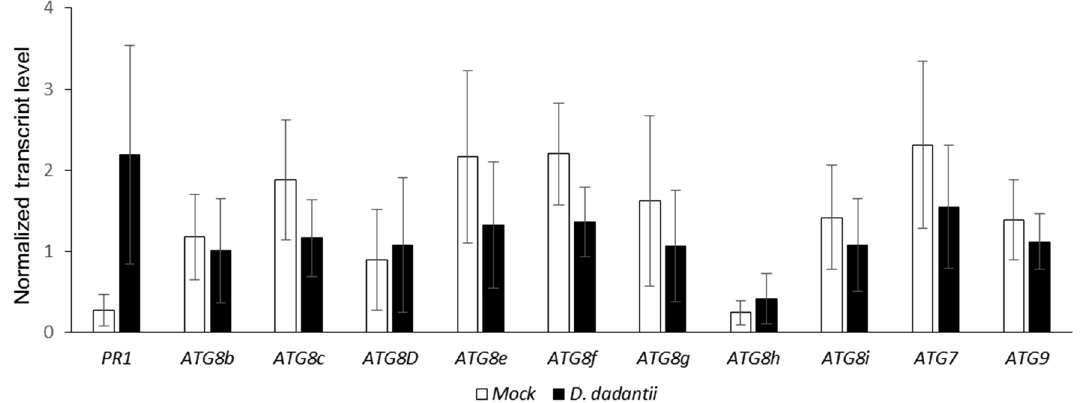
Figure 2. Expression of ATG genes upon D. dadantii infection. Plants were infected or mock treated then leaves were harvested 24 h after treatment. Transcript levels were monitored by qRT-PCR and normalized against the transcripts of the reference genes APT and Clathrin. Bars are standard deviation, N = 4. Experiments were performed 3 times with similar